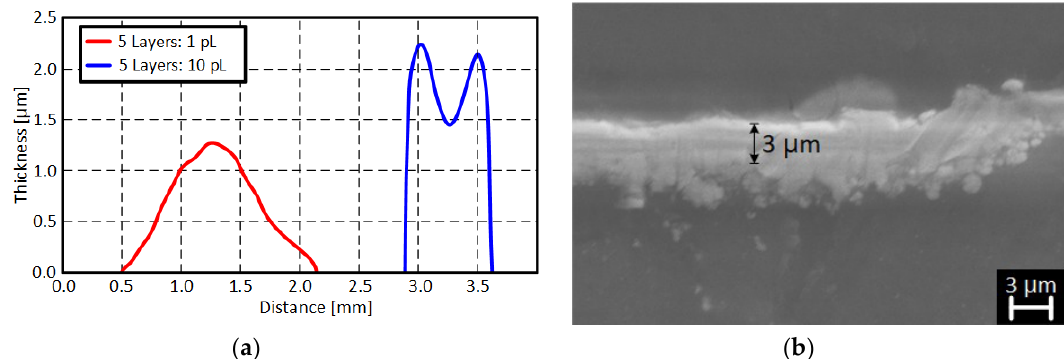
Sensors 2019 , 19 , x 6 of 8 Figure 7. Measurement results. ( a ) The loop antenna and ( b ) RF-DC converter. A 4.72 kΩ resistor was connected to the designed far-field RF energy harvester to validate the proposed autonomous battery-less self-sustainable wireless sensor system since the load resistor drained current of 190.7 μA at 900 mV (delivered DC power to the load is about 171.6 μW). The delivered power was high enough to drive an ultra-low power microcontroller unit (MCU) continuously because the ultra-low power MCU drains about 70 μA from a 900 mV voltage source at 1 MHz clock speed (MCU consumes about 63 μW) [17]. The measured voltage at the resistive load of 4.72 kΩ was about 900–950 mV when the received power by the loop antenna was higher than 0 dBm. The corresponding ambient power density was about 6.5 μW/cm 2 . It was demonstrated that the proposed RF energy transfer/harvesting system was able to power-up a low-power MCU continuously. 2.3. Direct Silver Nano-Particle Printing and Indirect Cssu Film Deposition In this section, the two metallization methods (direct and indirect printing) are discussed in detail. Both printing technologies deposit thin metallic layer which thickness is less than 5 μm as shown in Figure 8. Figure 8a shows the cross-section of the printed silver nano-particle ink for five times with 1 pL or 10 pL cartridge. The coffee ring effect was observed when a 10 pL droplet cartridge was used. The coffee ring effect occurs because of the different evaporation rate (drying rate) across the printed pattern or droplet. It can be suppressed by adding cellulose fiber, controlling the substrate temperature, or mixing low boiling point and high boiling point solvents [18–20]. A triangular cross- section was printed without the coffee ring effect for a 1 pL droplet cartridge because the amount of ink drop was small enough to dry at the same rate across the droplet. Figure 8b shows a SEM (Scanning Electron Microscope) image of the indirectly printed Cu film grown for 40 minutes in a CuSO 4 bath. The thickness of the Cu film was 3 μm which was about 1 μm thicker than the directly printed silver nano-particle layer printed 5 times with a 10 pL cartridge. The measured surface roughness was about 14.4 nm for the directly printed silver nano-particle pattern and 250 nm for the indirect Cu film printing method. This was because the grain size of the grown Cu was much larger than the silver nano-particles as shown in the SEM images of the printed conductive films (Figure 9). The extracted electrical conductivity values are also shown in Figure 10. The directly printed silver